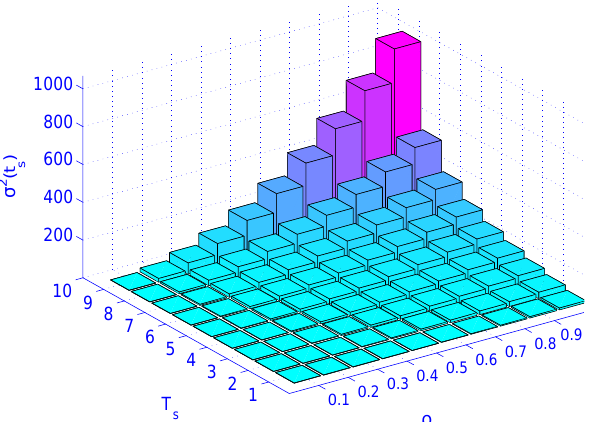
Figure 10. The impact of load ( ρ ) and service rate ( T s ) on jitter σ 2 ( t s ) .